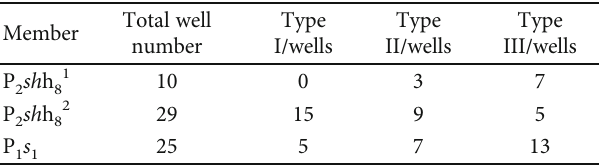
Table 3: Statistics of classi fi cation and evaluation of the reservoir stratum of members in the Su-54 block of the western Sulige gas fi eld.